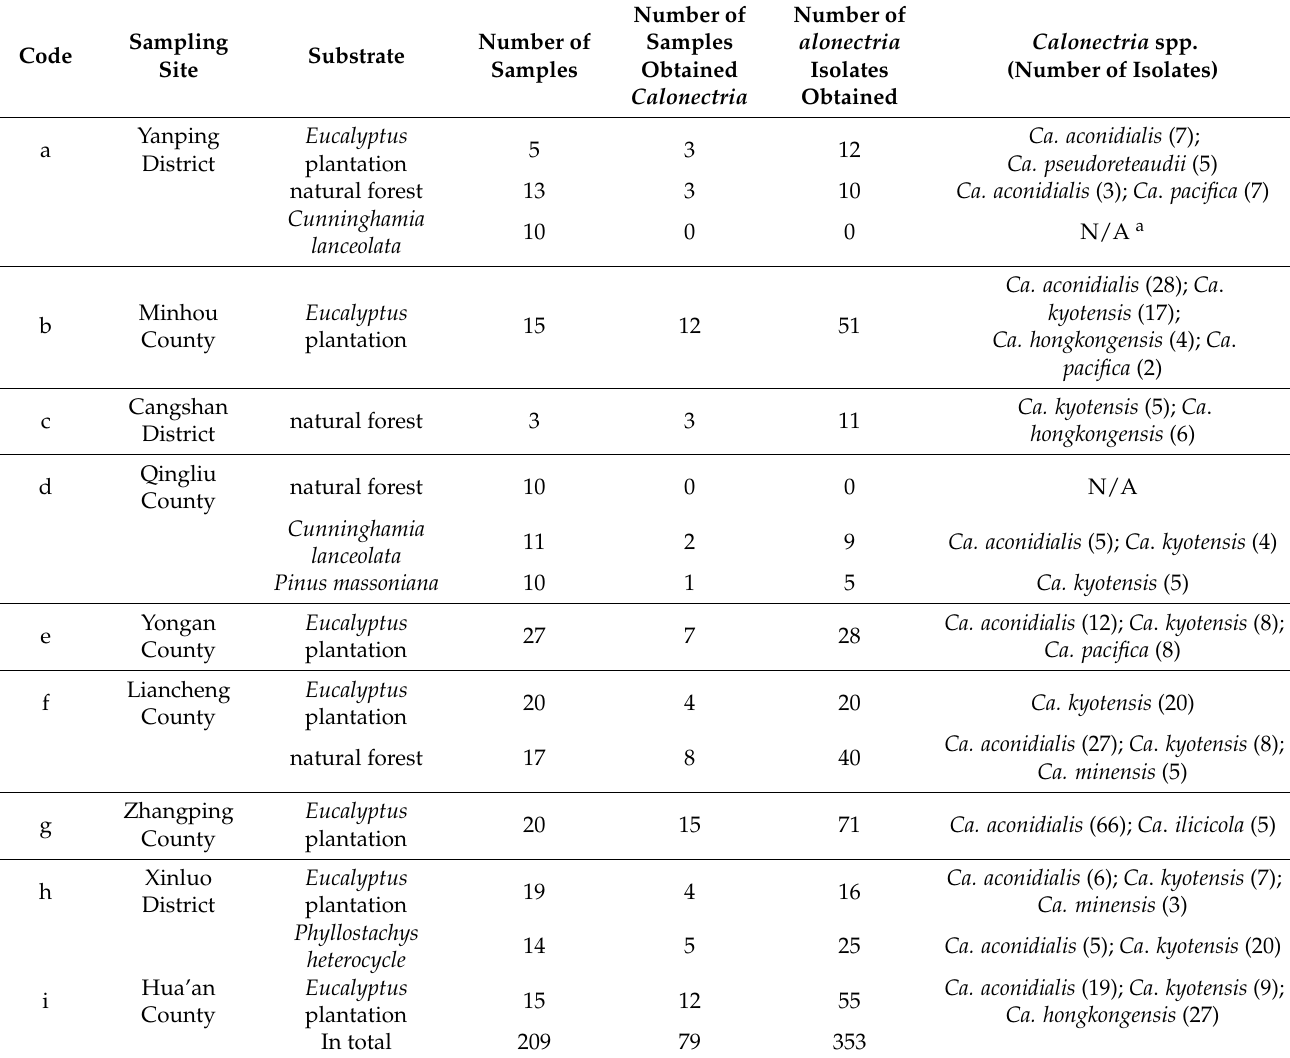
Table 1. Details of soils sampled, associated forest types and Calonectria spp.